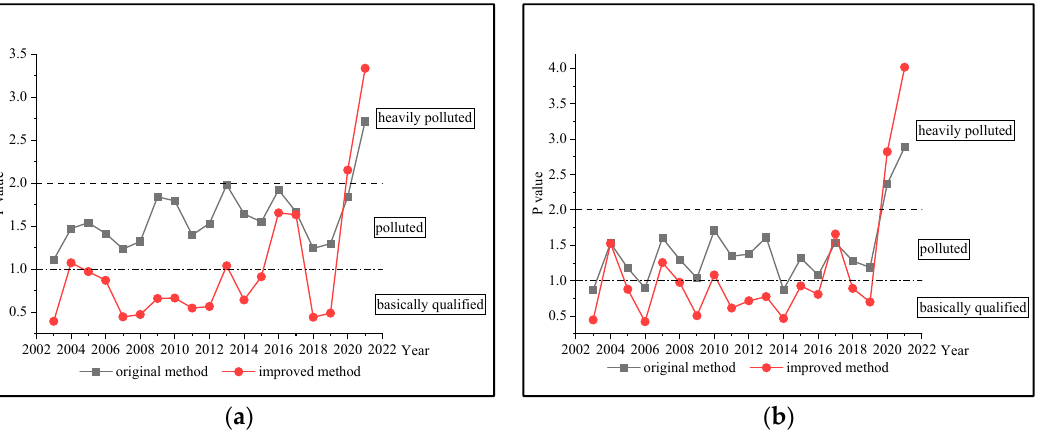
Figure 10. Comprehensive pollution index of the Taigou section from 2003 to 2021. ( a ) low water period (May), ( b ) high water period (September) Table 6. The original weights and improved weights of the three river sections.